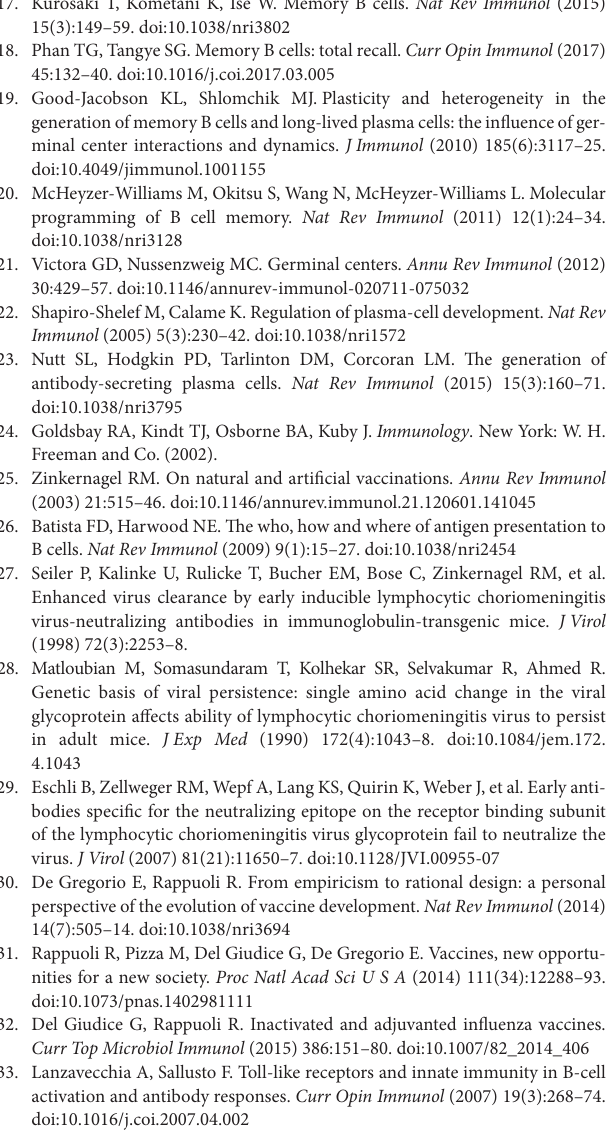
FigUre s2 | Flow cytometry gating strategy to identify proliferated and non-proliferated antigen-specific B cells. Glycoprotein 1 of lymphocytic choriomeningitis virus (GP1-LCMV) specific B cells purified from KL25 transgenic mice were labeled with CFSE and transferred into recipient C57BL/6 syngeneic mice, containing a different CD45 allele. The day after, adoptively transferred mice were immunized in one leg with GP1-LCMV alone or